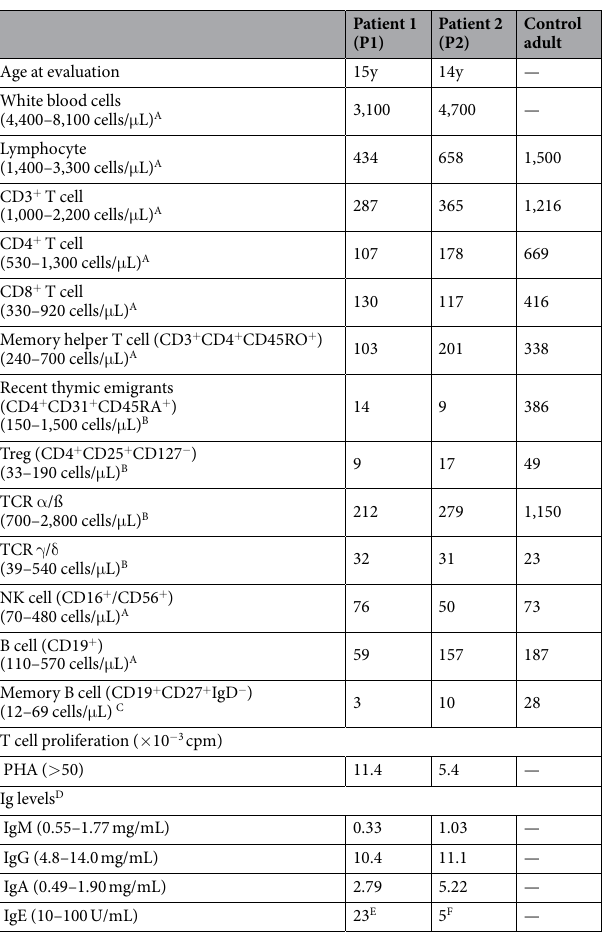
This transition mutation has been registered in the dbSNP database (rsID: rs201917359) with a minor allele fre- quency of 0.0008. These results suggest that the causative mutations are strongly linked to the compound heterozygous muta- tions, namely the c.209_212 del GCTT and the c.691C > T in the TYK2 genes of these two patients. Assessment of type I IFN response. To probe possible association between the TYK2 variants and cellular functions, we measured the TYK2 mRNA and protein levels in EBV-transformed human B-cell lines (EBV-BCLs) prepared from PBMCs of healthy donors and P2. The result indicated that no significant reduction of the mRNA level was observed in P2 compared with healthy donor controls (Supplementary Fig. S2). In contrast, the immu- noblot analysis showed that the TYK2 protein level (Fig. 1d, Supplementary Fig. S2) was low in P2 (47–51% relative to the control donors). The reduction was similarly observed in primary CD4 + T cells derived from P2, whereas the TYK2 protein levels in CD4 + T cells from her parents were similar to the levels in the healthy control (Supplementary Fig. S3). These results suggest no significant impact of single allelic variation for the c.209_212 del GCTT or the c.691C > T on the TYK2 expression. Next, to assess the function of TYK2 in the patient, the levels of STAT1 (Tyr 701), STAT2 (Tyr 690) and STAT3 (Tyr 705) phosphorylation in patient-derived EBV-BCLs and T cells upon stimulation with IFN- α and IFN-ß were analyzed by immunoblotting (Fig. 3a) and compared by quantifying the gel images (Fig. 3c,e and g). The relative expression level of STAT1 was less than 50% with or without IFN stimulation in the patient-derived cells compared with the control cells (Fig. 3b). However, the ratio of phosphorylated STAT1 (pSTAT1) to STAT1 was 2-fold higher in the P2-derived cells than in the control cells, suggesting that the patient-derived cells responded to type I IFN normally or even better than the healthy donor cells (Fig. 3c). In contrast, the relative expression levels of STAT2 (Fig. 3d) and the IFN-induced phosphorylated STAT2 (Fig. 3e) were similar between the P2 cells and the control cells. The levels of STAT3 exhibited a pattern similar to that of STAT2 (Fig. 3f,g).